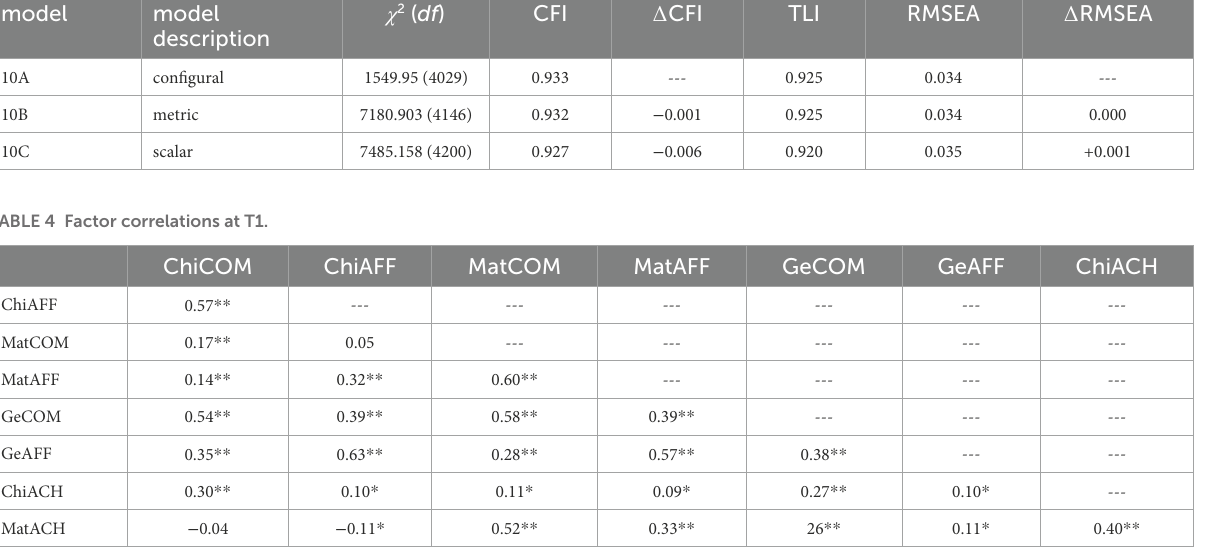
TABLE 3 Results of the measurement invariance tests of model 10. model